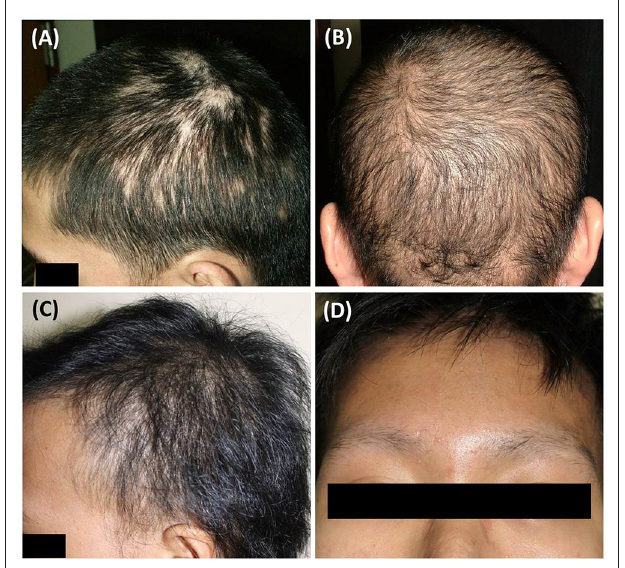
FIGURE 1 | Clinical manifestations of syphilitic alopecia: (A) moth-eaten alopecia; (B) diffuse alopecia; (C) mixed pattern; (D) alopecia of the eyebrows. TABLE 2 | Trichoscopic findings of Thai patients with syphilitic alopecia. Trichoscopic features Pattern of syphilitic